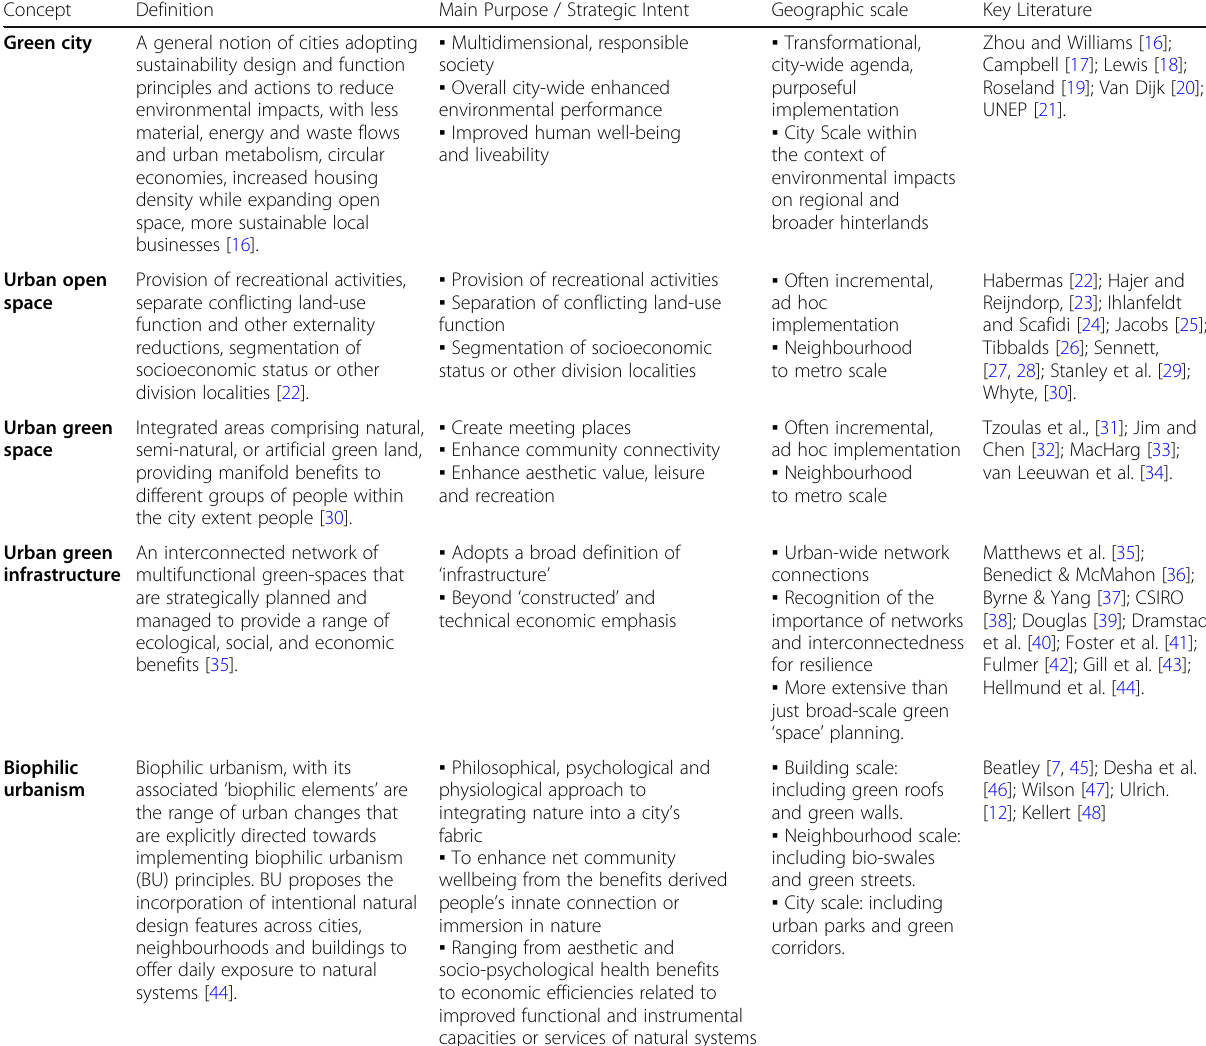
Table 1 An overview of key concepts related to action for integrating nature within cities